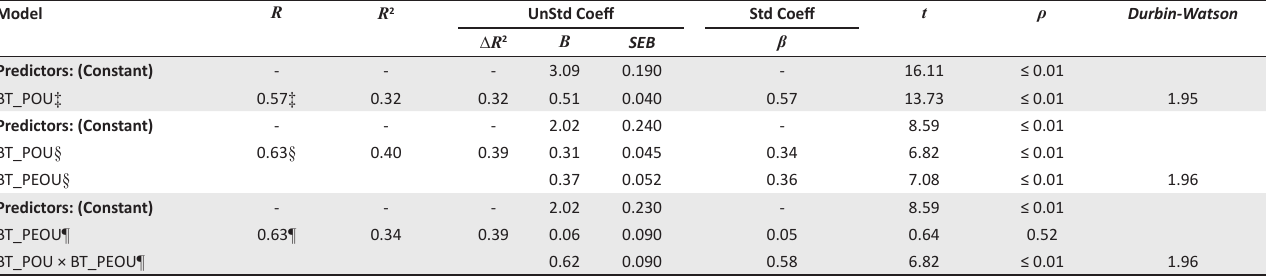
TABLE 1: A summary general linear modelling for predicting business event tourist’s intention to use online technology † (initial model to obtain residuals). Model